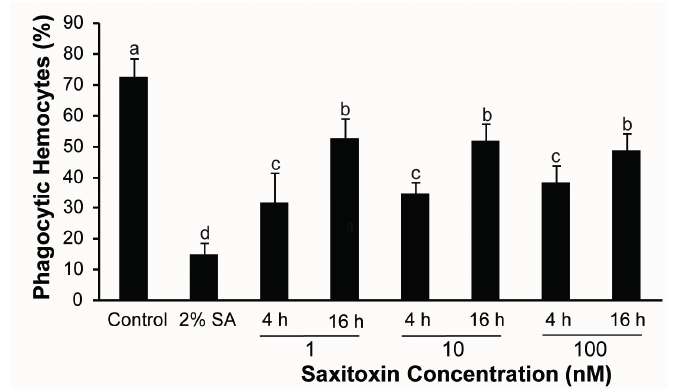
Figure 2. Effect of saxitoxin (STX) on the phagocytic activity of hemocytes. Hemocytes were pre-incubated with STX for 4 or 16 h and then incubated with 0.2% FITC-labeled zymosan for 1 h at 20 °C or co-incubated with 2% sodium azide. Phagocytic cells were analyzed by fluorescence microscopy. Bars represent the mean ± standard errors ( n = 3 cultures of hemocytes). Different superscripts indicate statistically-significant differences ( p < 0.05; Kruskal–Wallis/Mann–Whitney) at 4 and 16 h after incubation with STX as compared to the control group. SA: Sodium azide.